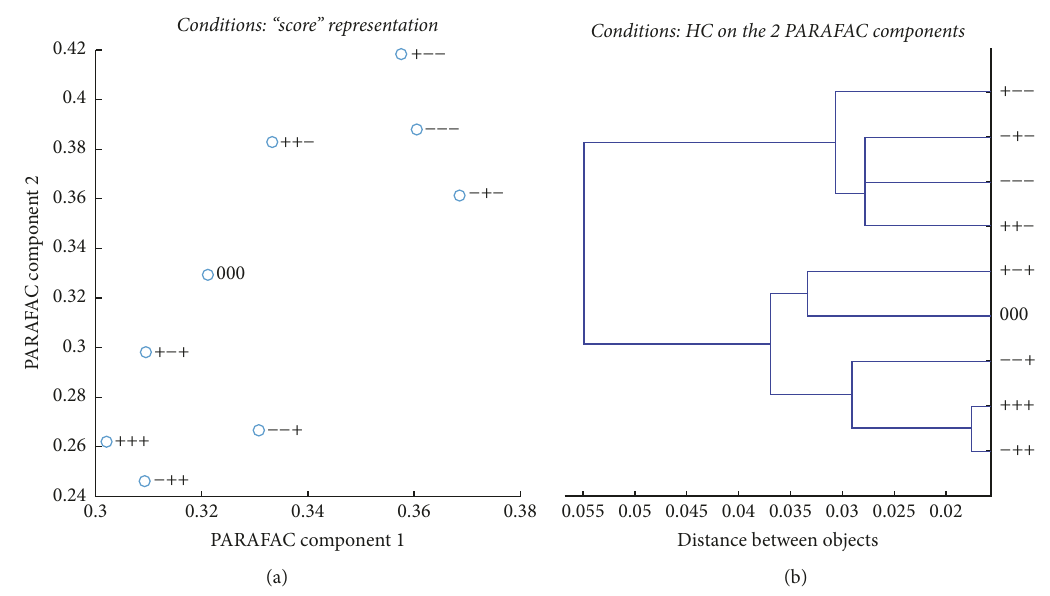
Figure 7: PARAFAC analysis of the experimental conditions: the two columns of matrix 𝐸 used as 𝑥 and 𝑦 coordinates (a) and HC performed on these coordinates